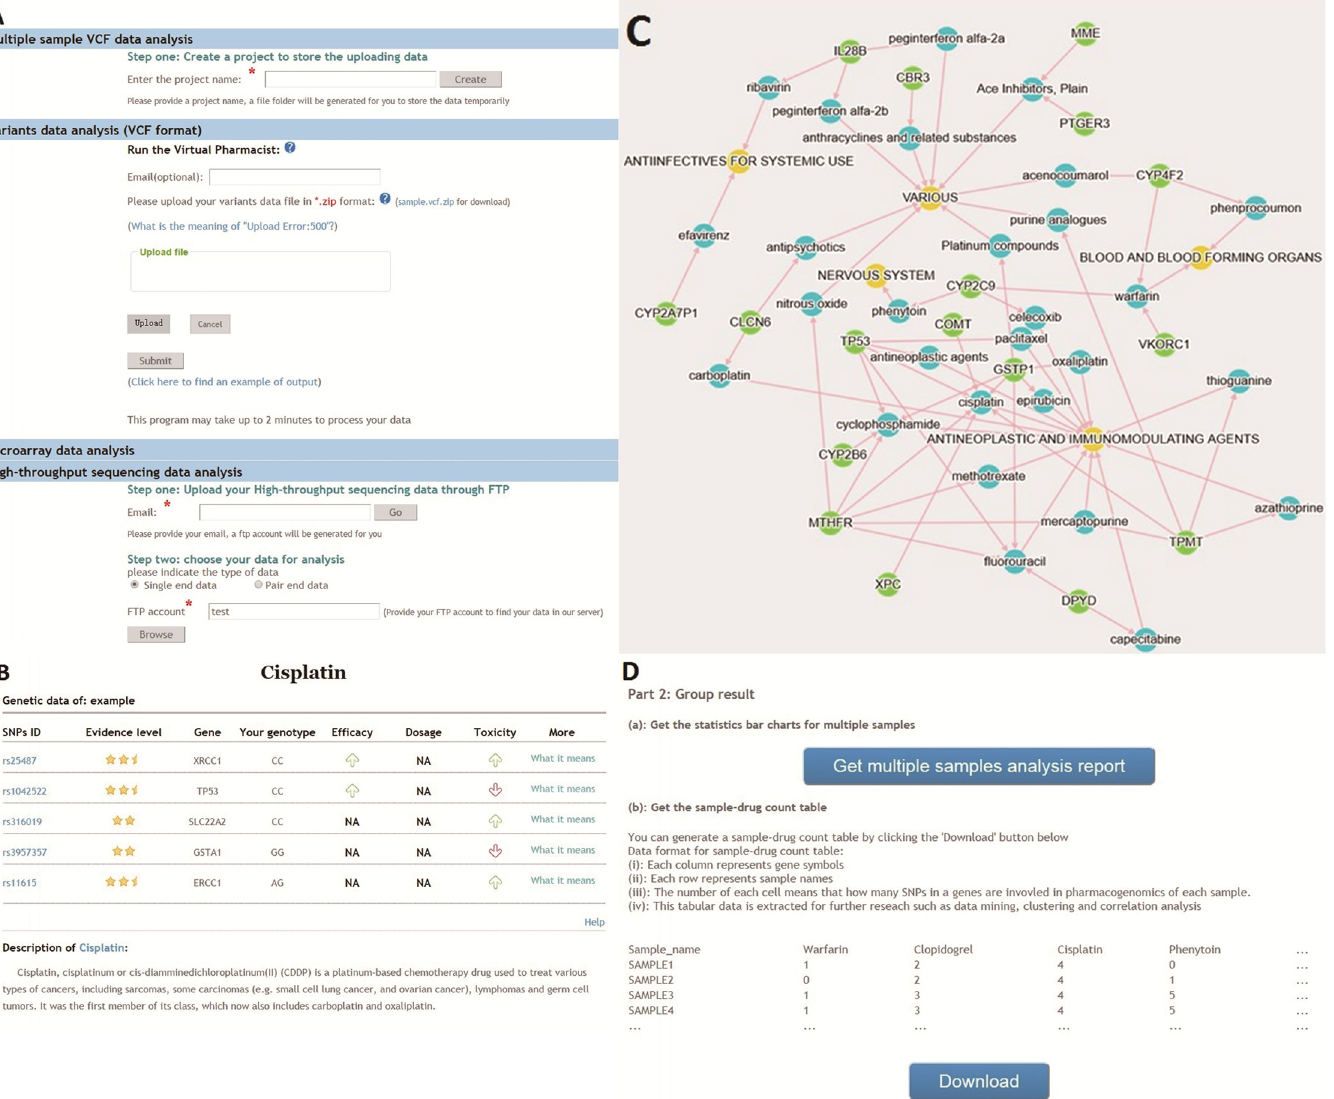
Fig 2. User interface and representative result output of Virtual Pharmacist (VP). (A ) VP accepts various data format as input; for example, VCF format files, high-throughput sequencing data, and microarray SNP data. ( B ) Cisplatin output as a representative result output. VP reports the SNP ID, evidence level, gene, genotype, efficacy, dosage, toxicity, and detailed description. ( C ) Network view of drug-gene interaction. Green, blue, and yellow circles in the graph represent a specific gene, drug name, and drug category, respectively, based on the DrugBank database. A drug functional classification and a gene are connected if a variant of the gene affects the response of the drug. ( D ) User interface for a representative multiple sample result. VP can analyze multiple VCF data files (each data file should contain just one sample) and calculate the statistics of drug response in a population. Furthermore, VP can provide sample-drug and sample-gene count tables to users for data mining and association